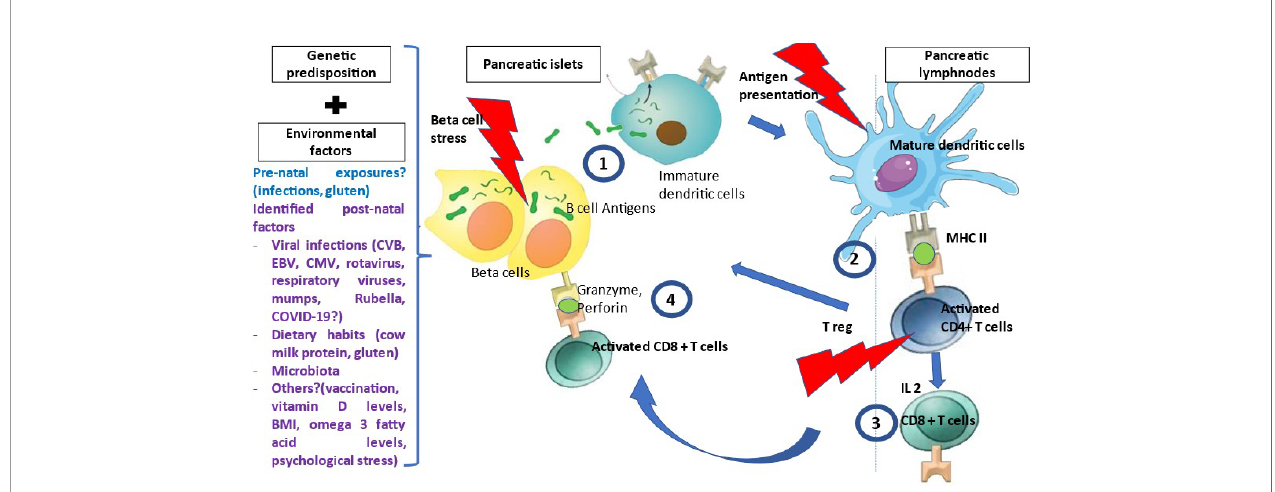
FIGURE 1 | Pathophysiology of T1D. Many environmental factors were associated with T1D development. The initial mechanism that triggers autoimmunity is unknown. In genetically susceptible patients, in the presence of environmental factors, b cells are stressed and release b cell antigens. 1- b cell autoantigens are processed by APCs and presented by HLA class II MHC molecules to the naïve CD4+T-cells in the peripheral LN. 2- CD4+ T-cells are activated and polarized towards a TH1 phenotype releasing cytokines, among which IL 2, INF gamma and IL-4 at the expense of regulatory T cells (T reg). 3 - This will activate and generate auto-reactive CD8+ T-cells, which recognized autoantigen peptides presented by HLA class I MHC molecules, migrate to the islets and liberate cytotoxic granzyme and perforin to destroy b